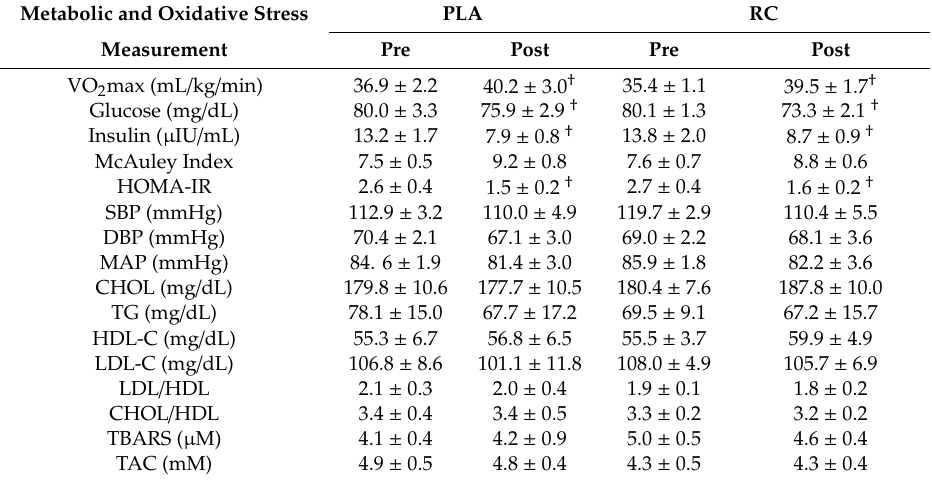
Table 4. The changes in VO 2 max and metabolic parameters and oxidative stress markers after eight weeks of intervention.